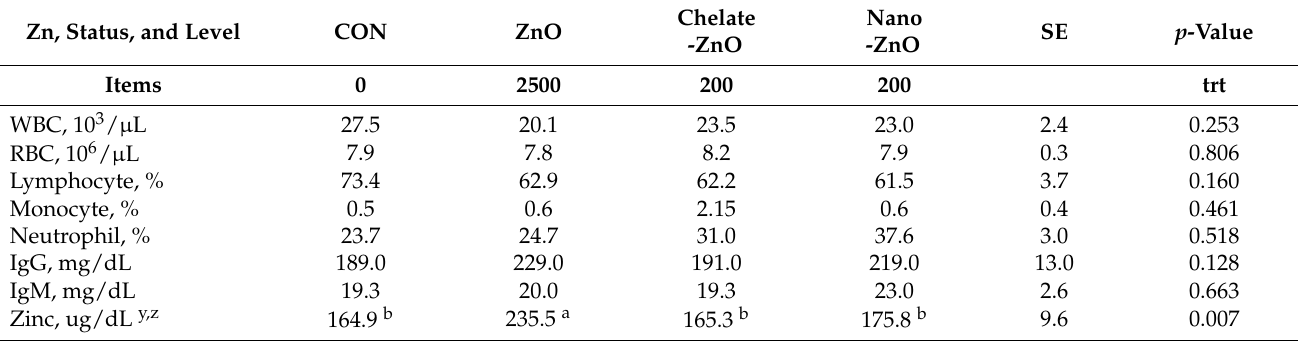
Table 6. Effects of different forms of zinc oxide on the blood profiles of weaned piglets ( n =